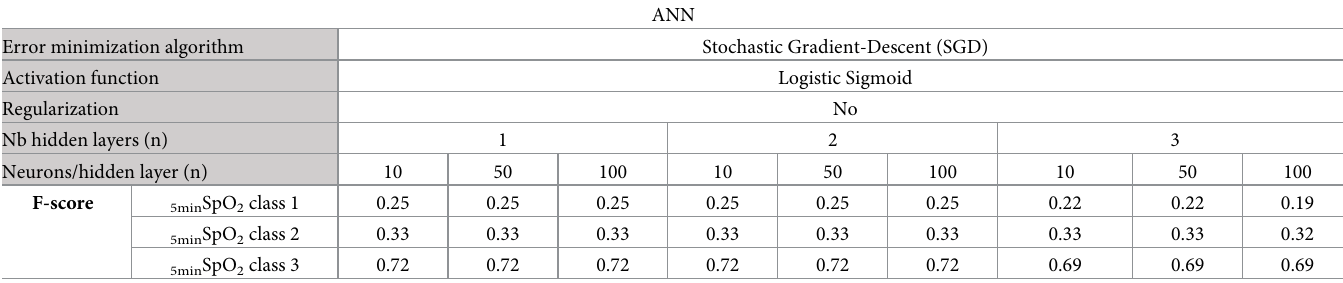
Table 4. Absence of impact on performance of the increase of neurons and hidden layers for artificial neural network (ANN). Example of the performance assessed by the F score on the balanced test dataset 3 (see Table 2).